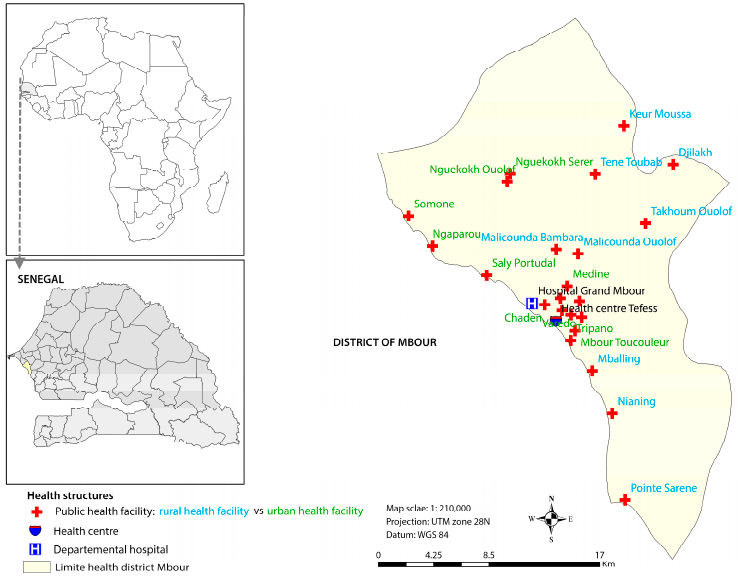
Figure 1. Map showing the study area and the location of the health facilities in the district of Mbour, Senegal.